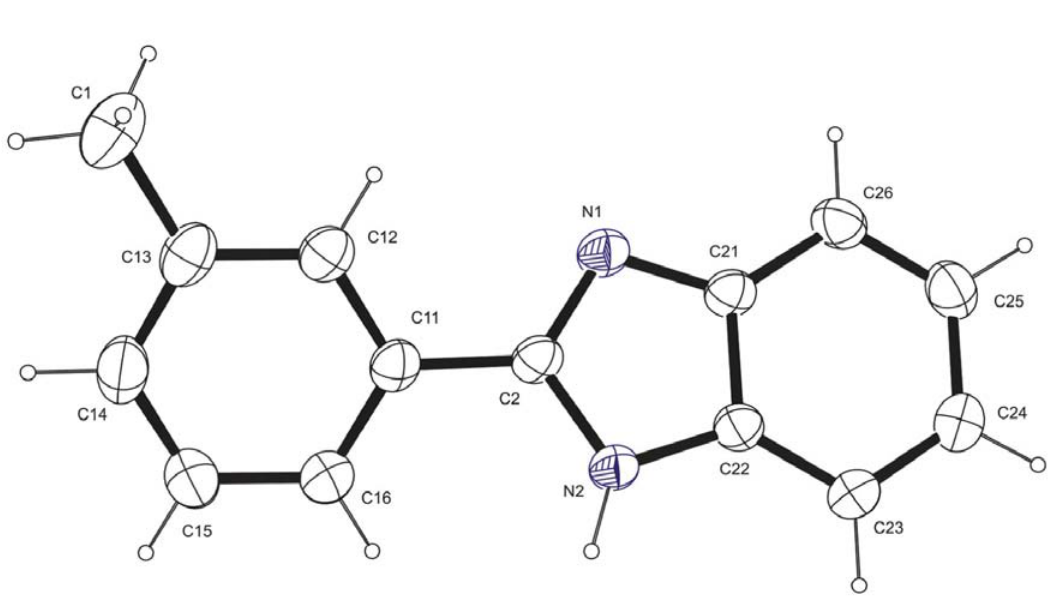
Figure 3. An ORTEP view of compound II showing 50% probability displacement ellipsoids and the atom